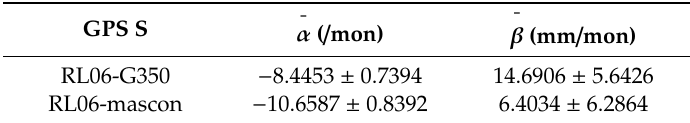
Table 1. Determined average slope α and o ff set β along with their respective uncertainties for converting GPS VCD into water